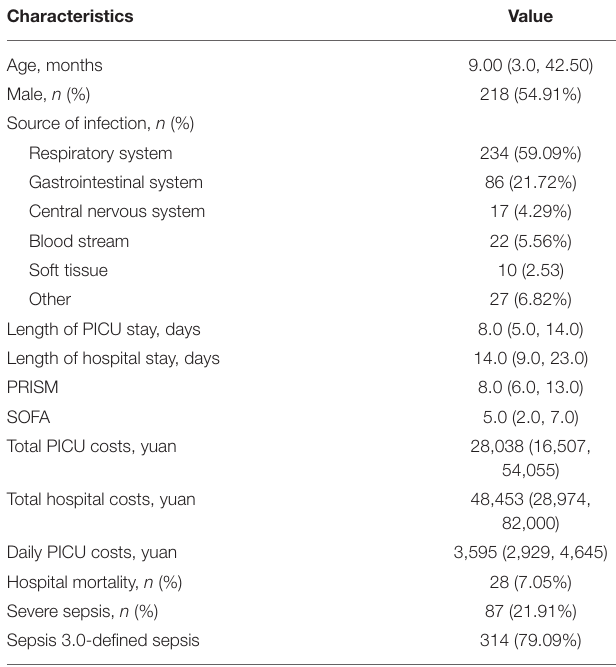
TABLE 1 | Baseline characteristics of the 397